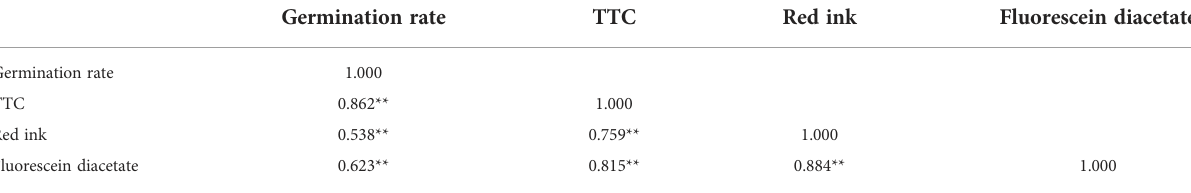
TABLE 4 Correlation matrix between the in vitro pollen germination rate (%) and the pollen viability.